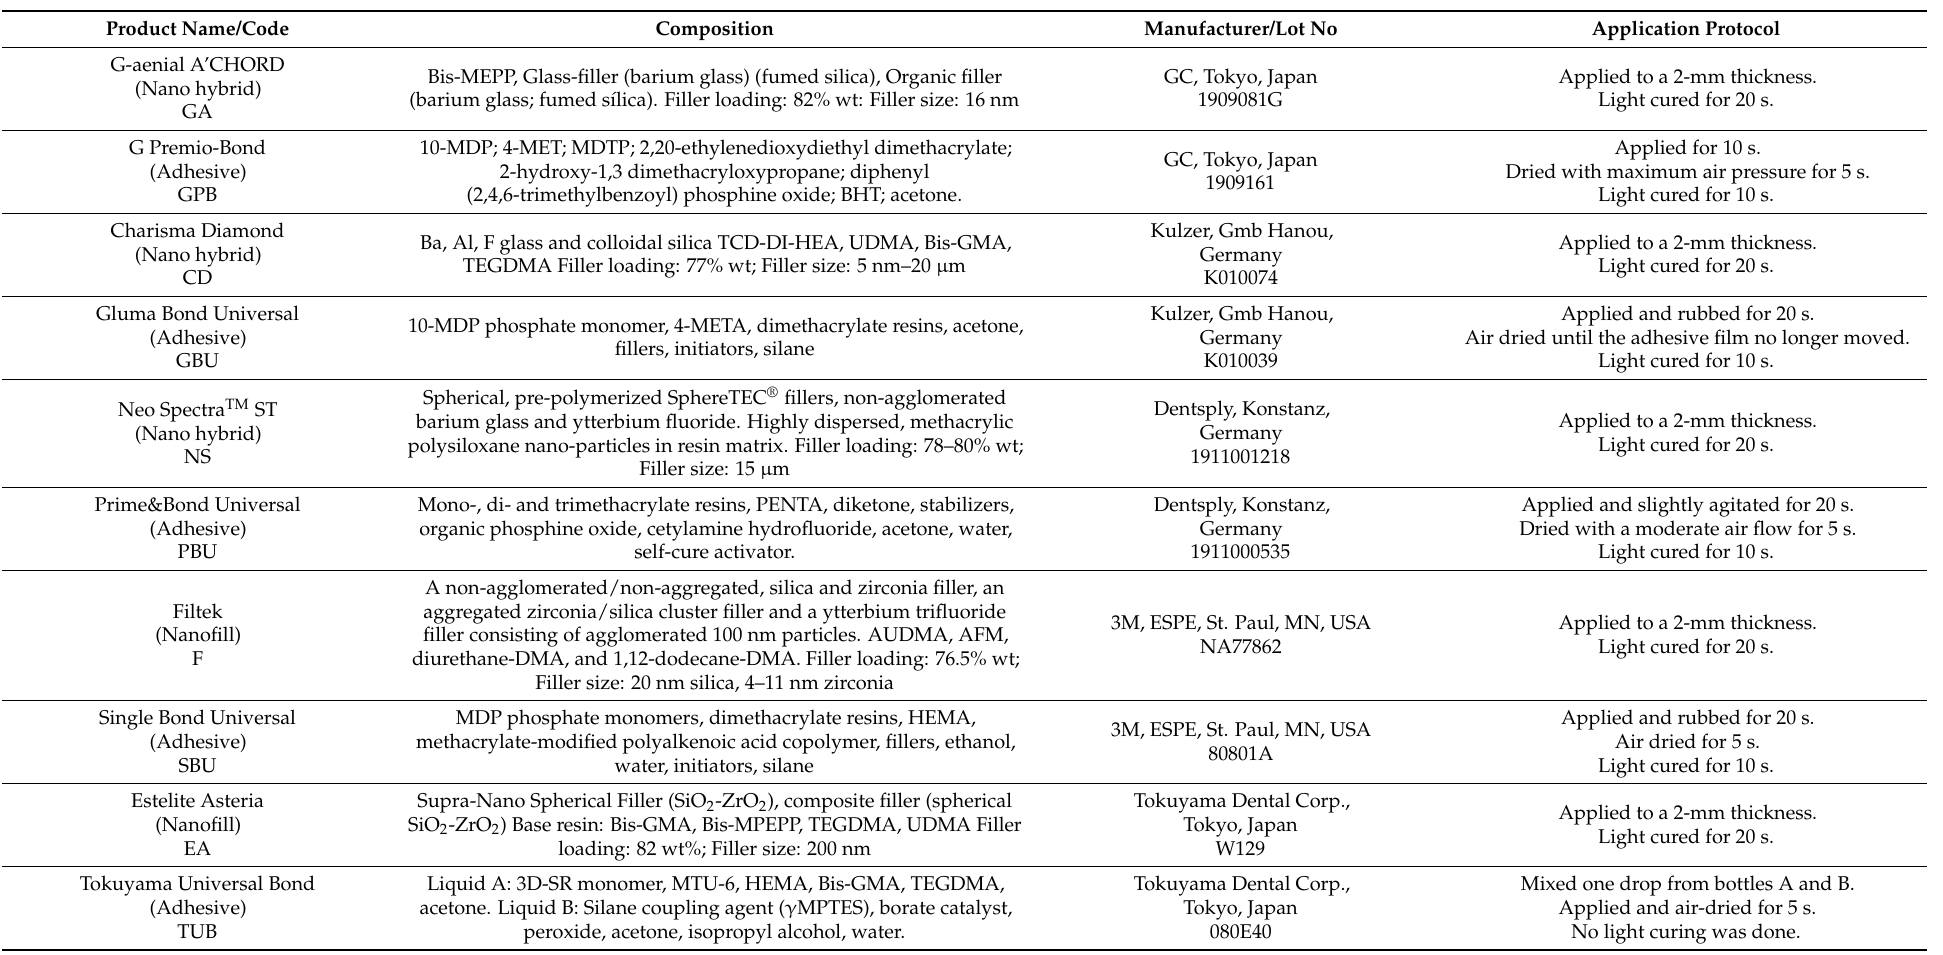
Table 1. The composite resins, as well as their compositions and respective adhesive systems, that were used in this